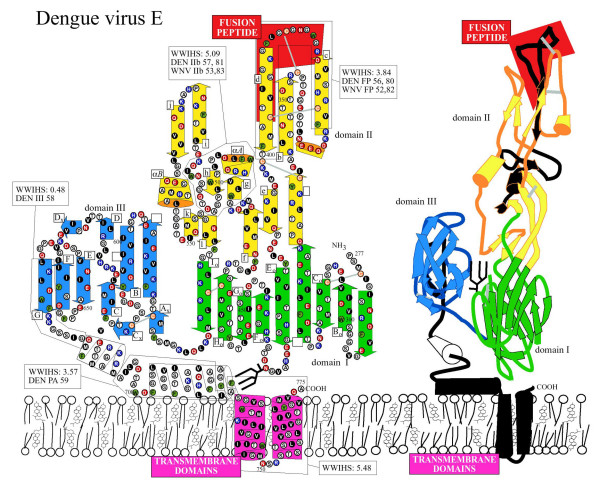
Diagramatic structure of DENV envelope protein showing inhibitory peptide regions. Grey lines: dicysteine linkages. Black stick figures: N-glycosylation sites. Regions with significant Wimley-White interfacial hydrophobicity scale scores were predicted with MPeX (Boxed in left depiction; black in right depiction). Sequences of DENV peptides and the location of WNV homologs are indicated.